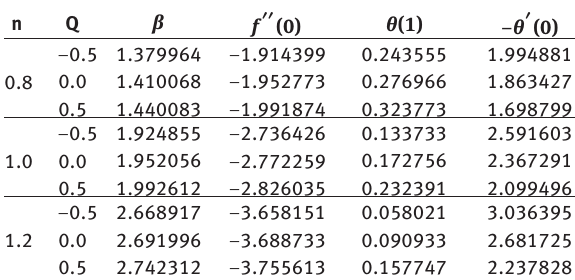
Table 8: Values for β , f (cid:2)(cid:2) (0) , θ (1) and − θ